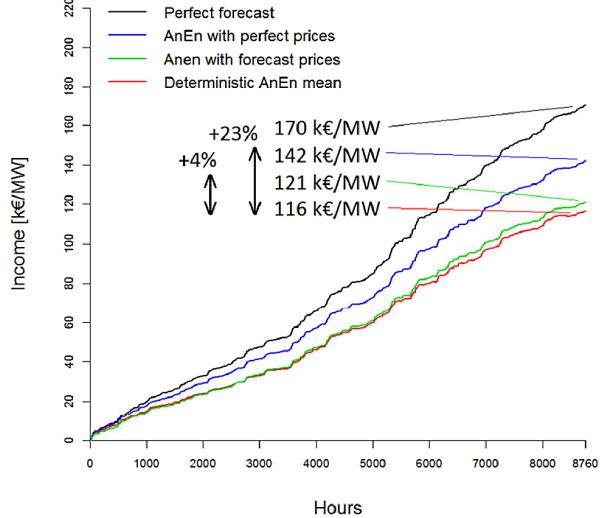
Figure 1. Cumulative income obtainable per 1MW of installed ca- pacity by a wind farm located in the south of Italy as a function of the hours of the year 2011. The di ff erent lines refer to the di ff erent approaches in bidding the wind energy in the